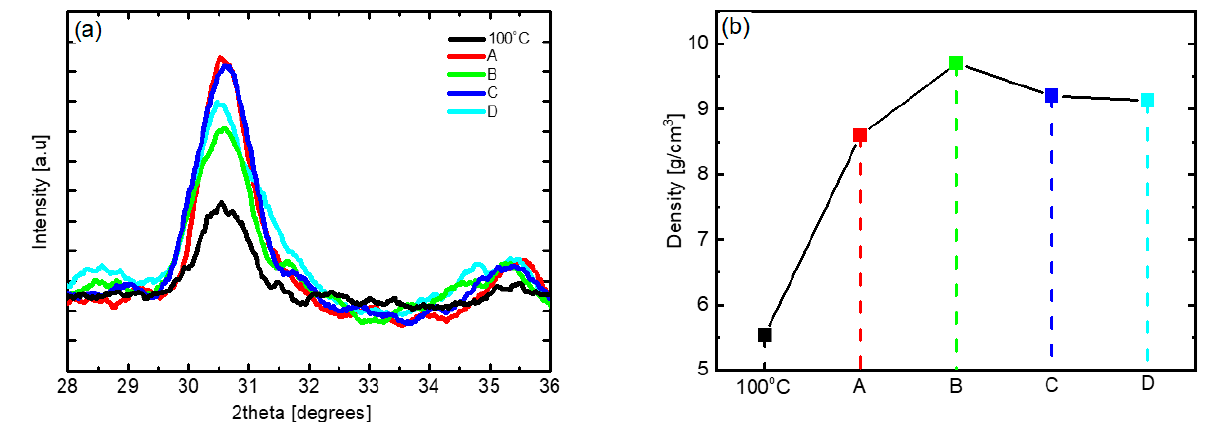
Figure 9. ( a ) XRD patterns and ( b ) thin film density according to the process improvement method of low-temperature-deposited HZO thin films; A: use of discrete feeding method, B: increase in RF plasma time, C: increase in gas flow, D: combined application of A, B, and C.